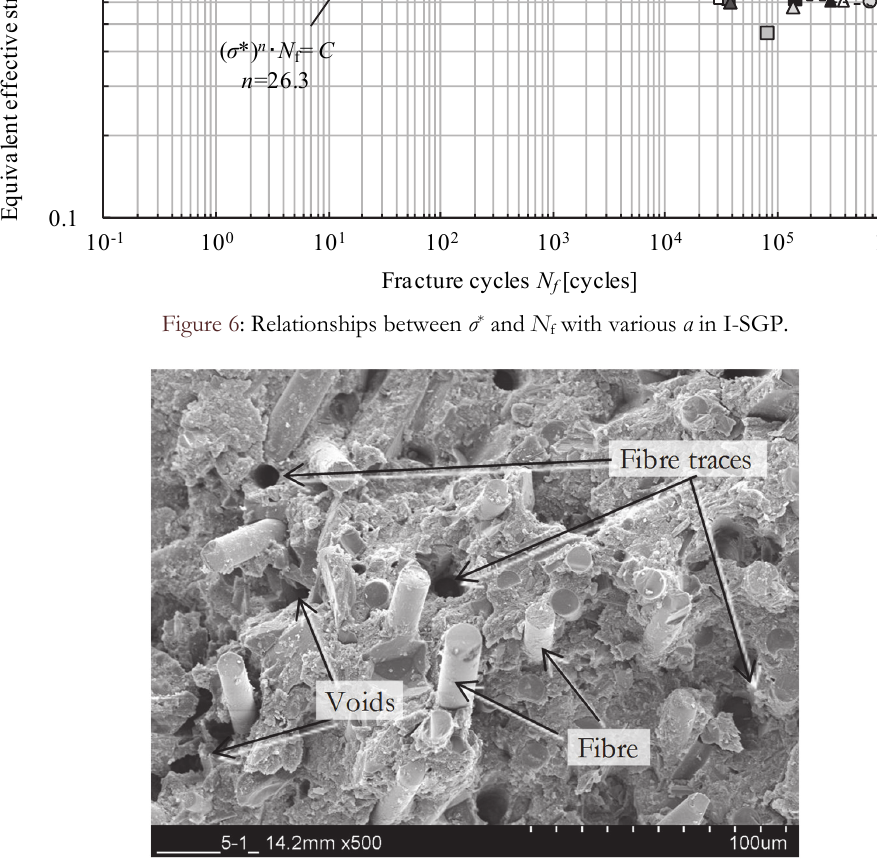
Figure 7: A typical tensile fracture surface situations with scanning electron microscopes in C-SGP. (05 V f